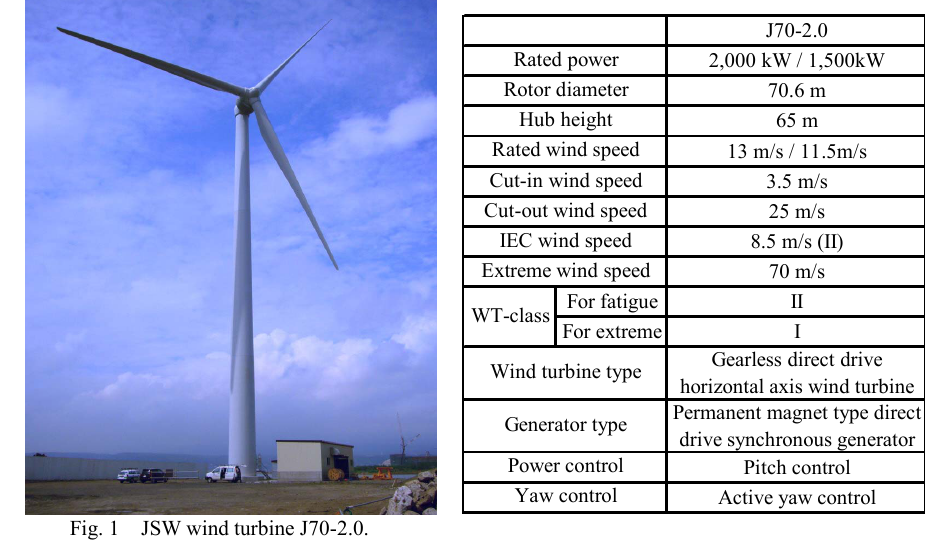
Fig. 1 JSW wind turbine J70-2.0.